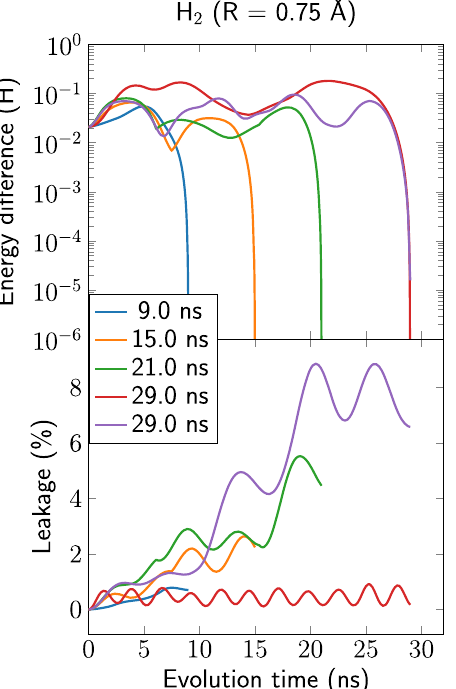
Fig. 4 Error in energy and leakage for H 2 . Energy difference shown between ctrl-VQE and FCI (top) and leakage (bottom) along the time evolution steps with optimal pulses of different durations for H 2 with a bond distance of 0.75 Å. The red and purple lines with T = 29 ns are distinct solutions to the same optimization. Optimized pulse parameters are provided in the